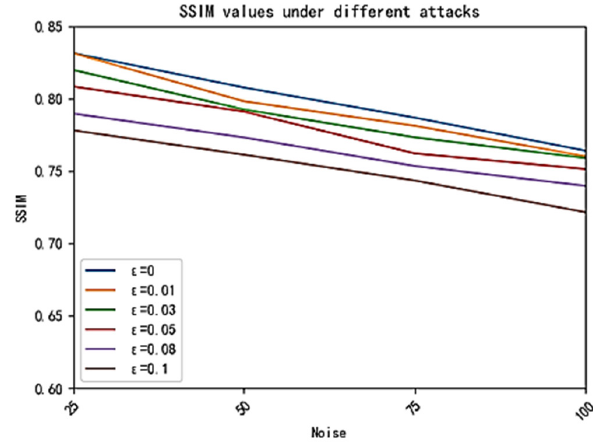
Figure 6. SSIM values under different levels of FGSM attacks.